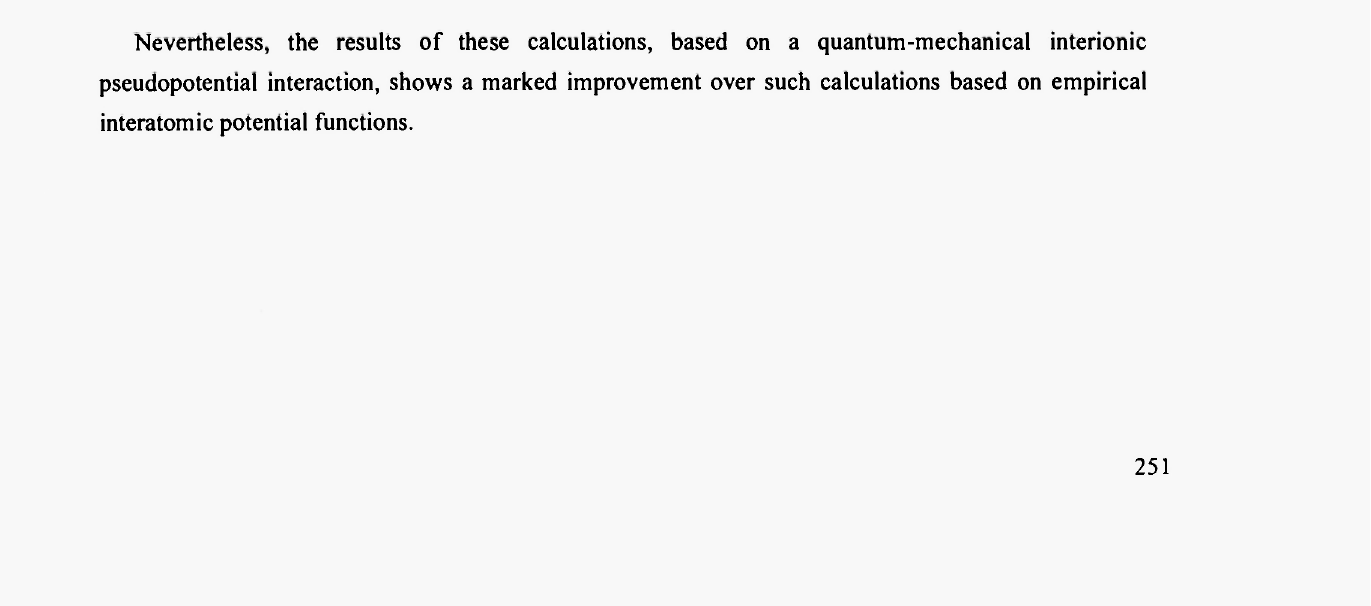
Fig. 21: B 4 as a function of (a j - a °) at different stages of